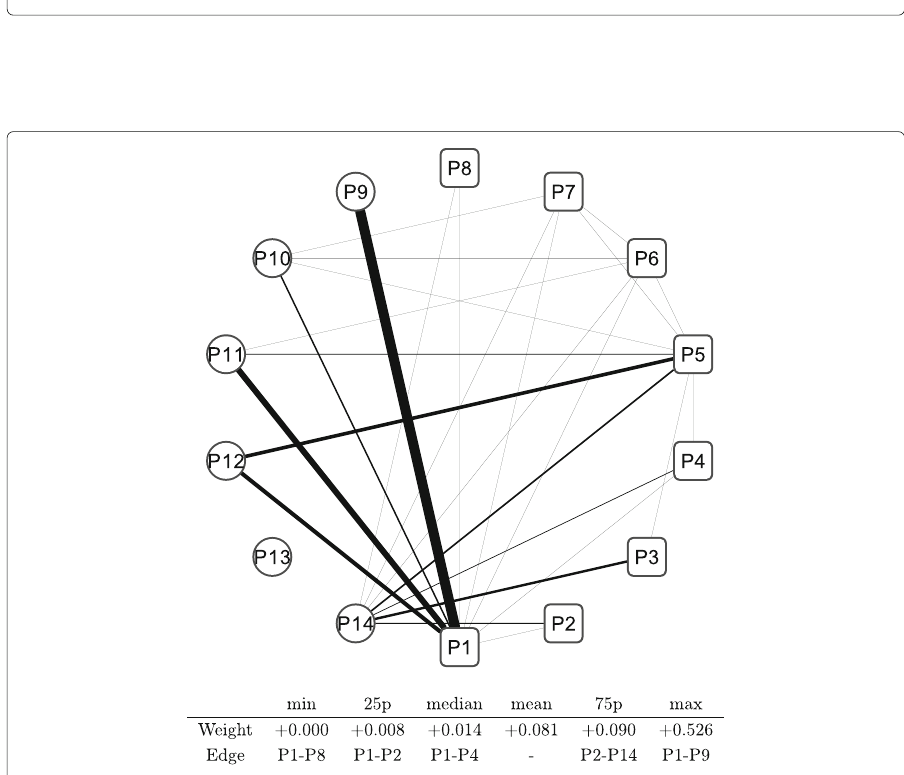
Fig. 13 Changes in network between sub-periods: T2–T1. Note: The network shows the difference between the sub-period T2 and T1. The edge weight (the edge width) is calculated by subtracting elements of the adjacency matrix of T1 from those of T2 described as T2 − T1. Only the edges that have positive weights (T2 > T1) are shown. The bottom table shows the quantiles of edge weights distribution with corresponding